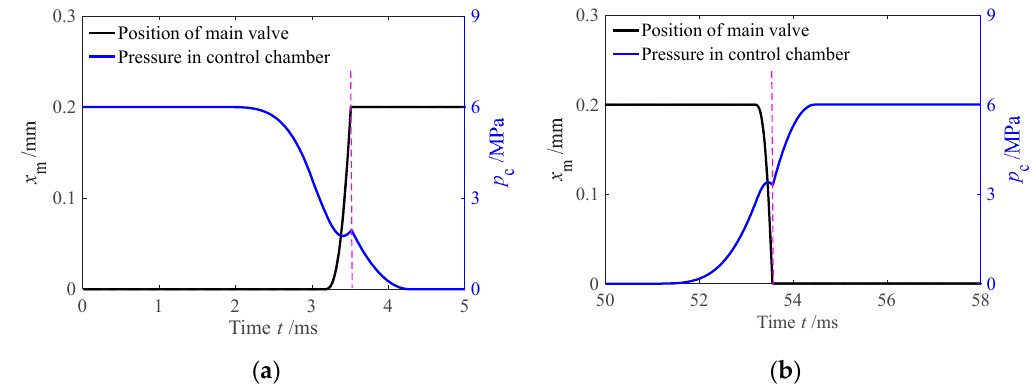
Figure 6. Relationship between the pressure and the main valve’s position: ( a ) Opening stage; ( b ) Closing stage.